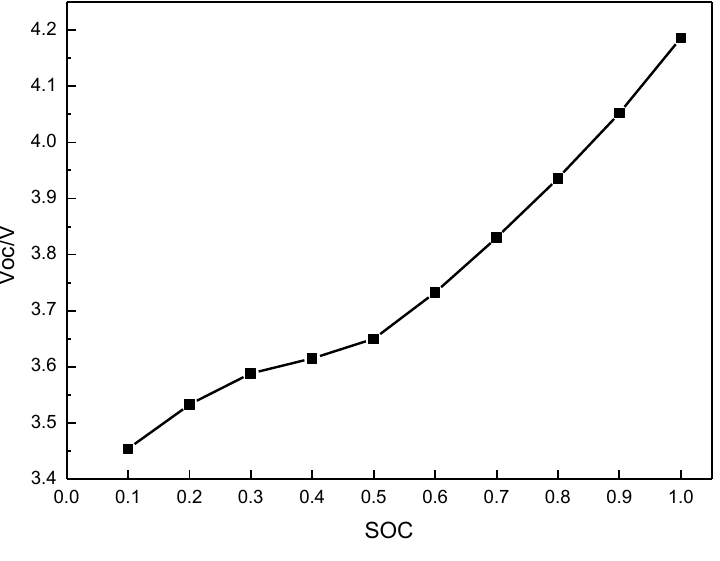
Figure 10. Change curve of Voc with SOC.